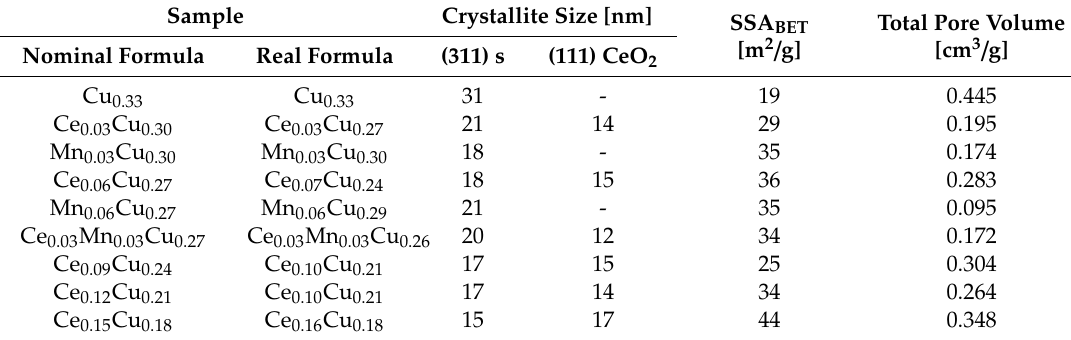
Table 1. Composition, crystallite sizes, and textural properties of Ce- and Mn-doped Cu–Al spinel catalysts.